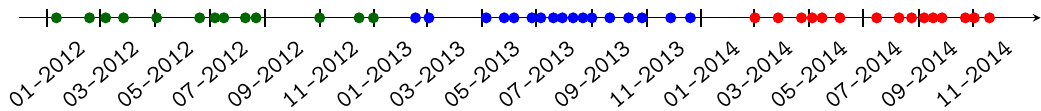
Figure 3. Formosat-2 acquisition dates in 2012 (green dots), 2013 (blue dots) and 2014 (red dots) used in this experiment.